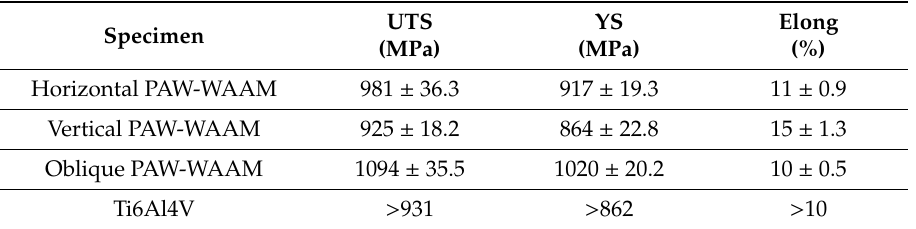
Table 4. Mechanical properties: ultimate tensile stress (UTS), yield strength (YS), and elongation at break (Elong). PAW-WAAM, plasma arc welding wire arc additive manufacturing.